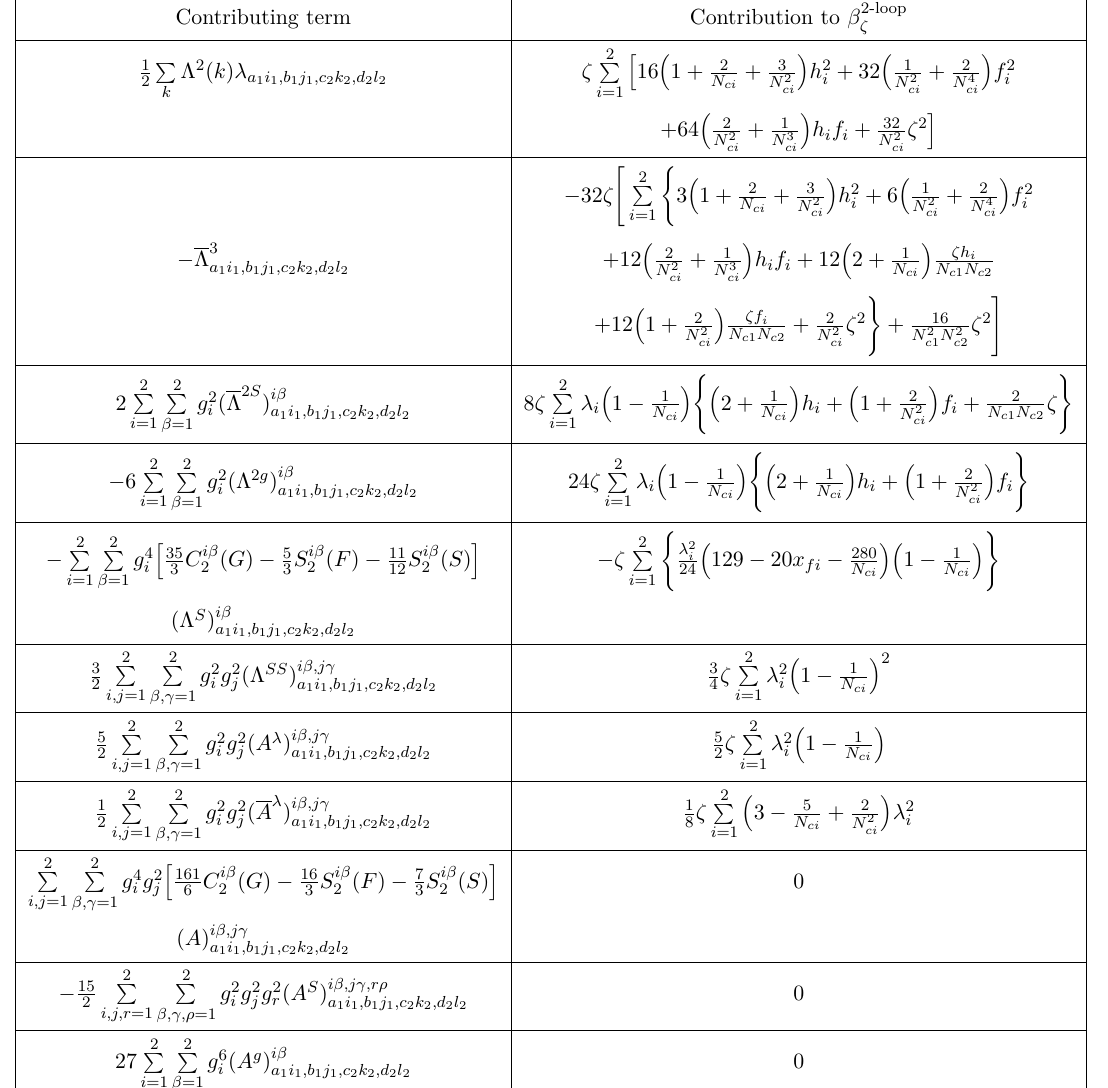
Table 5. Contribution of different terms to β 2-loop